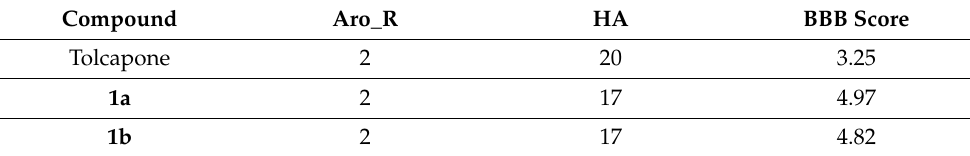
Table 3. Molecular Descriptors and BBB Score of tolcapone, 1a and 1b